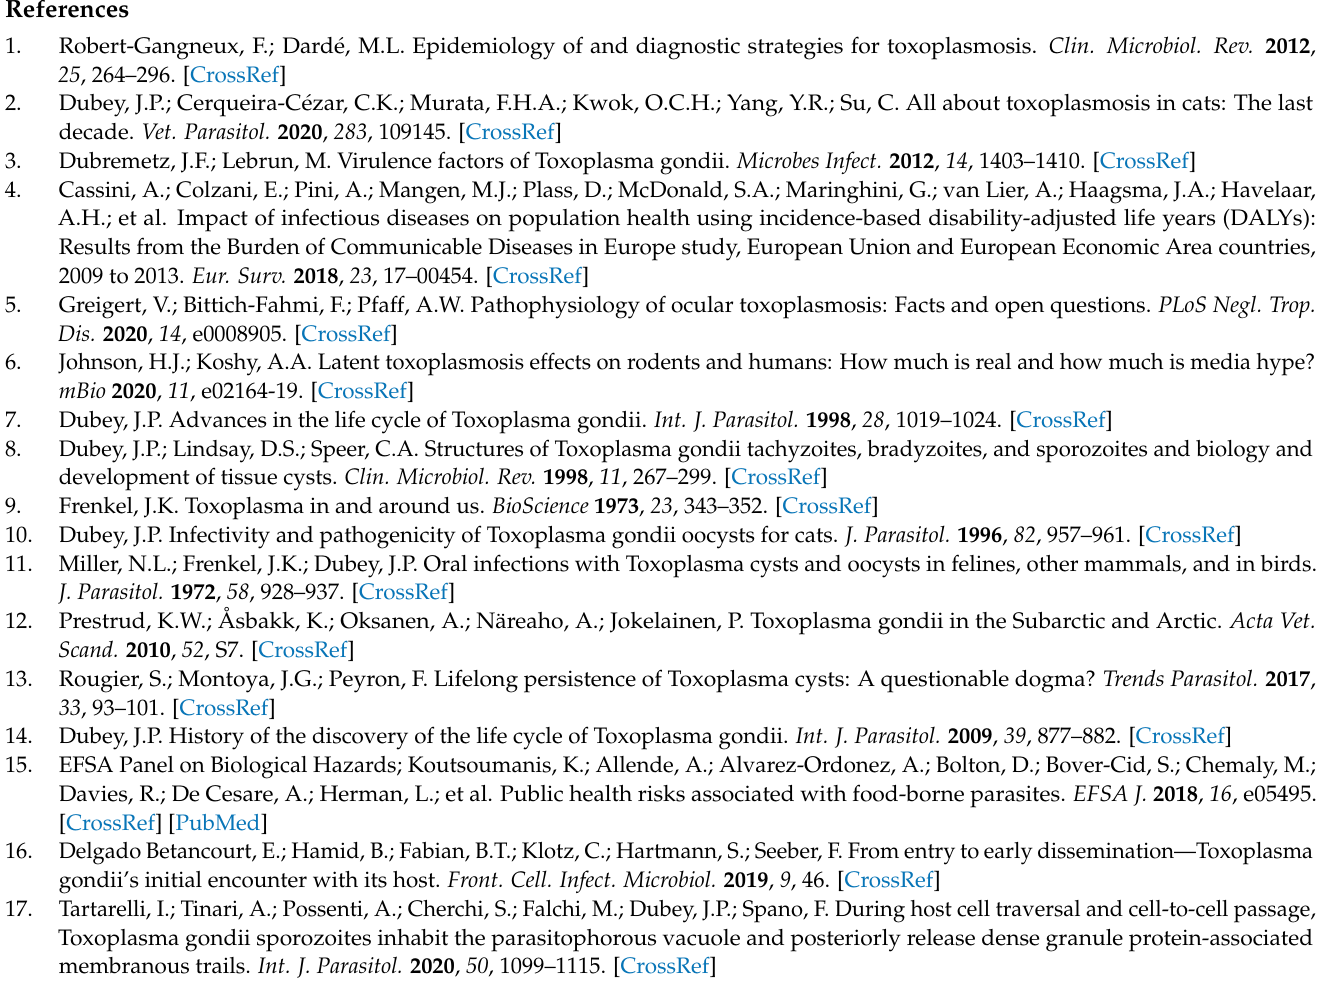
Table S2. Proteome-wide compilation of data for antigen